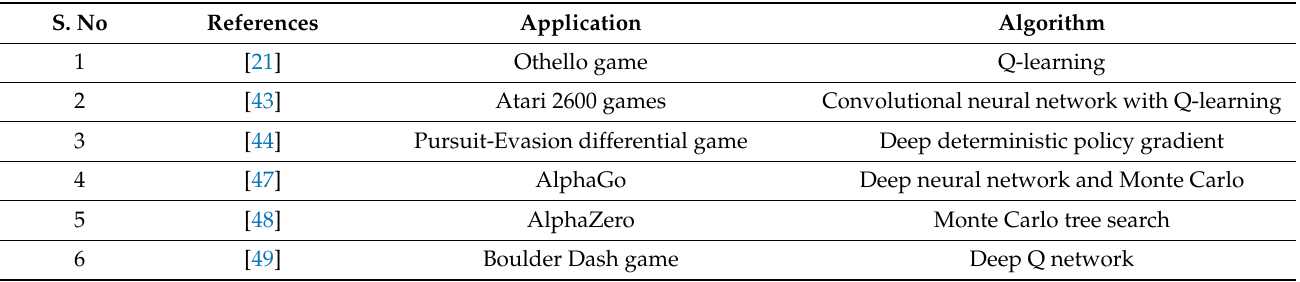
Table 2 lists the gaming applications implemented using RL. Table 2. Reinforcement learning applications in